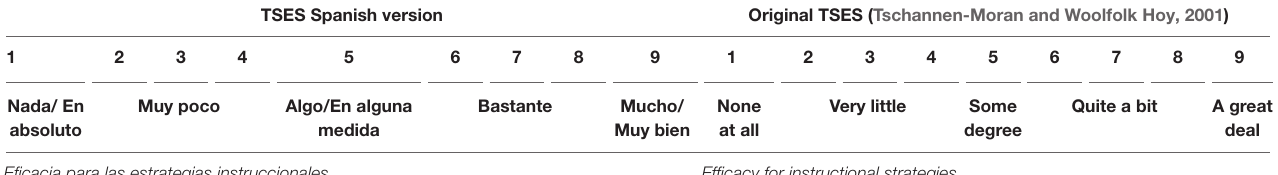
TABLE 2 | Spanish and original versions of the Teachers’ Sense of Efficacy Scale